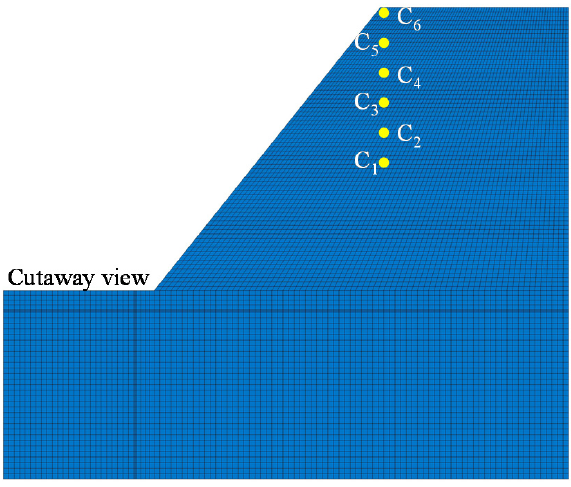
Figure 4. The feature points C 1 –C 6 . The comparative analysis of vertical and horizontal vibration velocities is shown in Figure 5. velocities in both vertical and horizontal directions showed amplification near the top of the slope. The variation of vibration velocity in the vertical direction was more significant than that in the horizontal direction. In the vertical direction, the simulated minimum blasting vibration velocity was 2.44 cm/s, and the maximum value was 4.52 cm/s, with an increase of 85.24%. In the horizontal direction, the minimum blasting vibration velocity was 1.72 cm/s, and the maximum value was 3.06 cm/s. The increase rate was 77.91%, lower than that in the vertical direction, indicating that the vertical vibration velocity was more affected by the elevation, which is consistent with the law obtained by the fitting